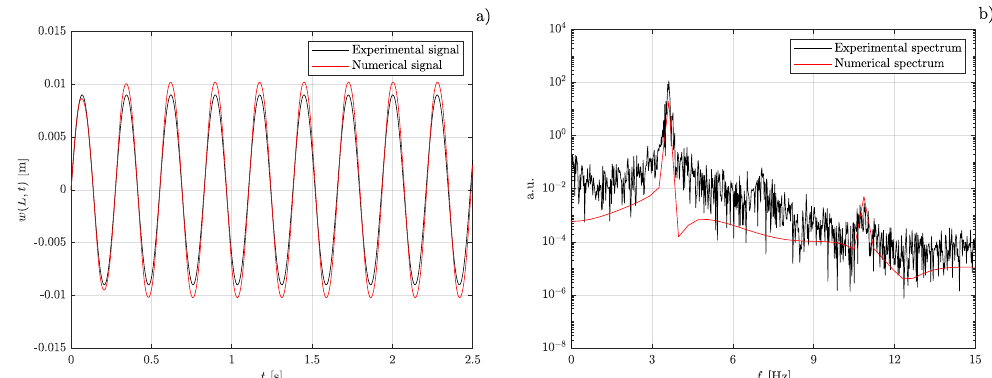
Figure 5. Comparison between experimental (black line) and numerical results (red line): time history of the tip motion ( a ) and frequency spectrum of the tip motion ( b ).